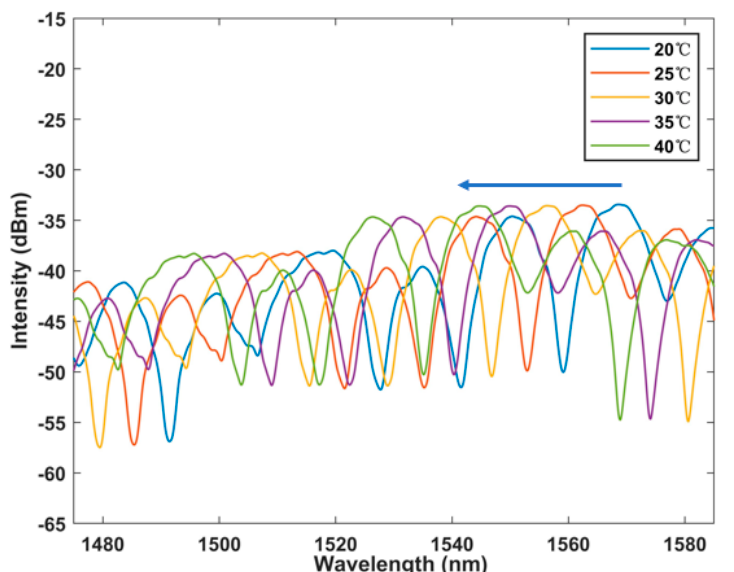
Figure 7. Output spectrum of temperature response with BBS in the range of 20 °C–40 °C within 5 °C per interval.